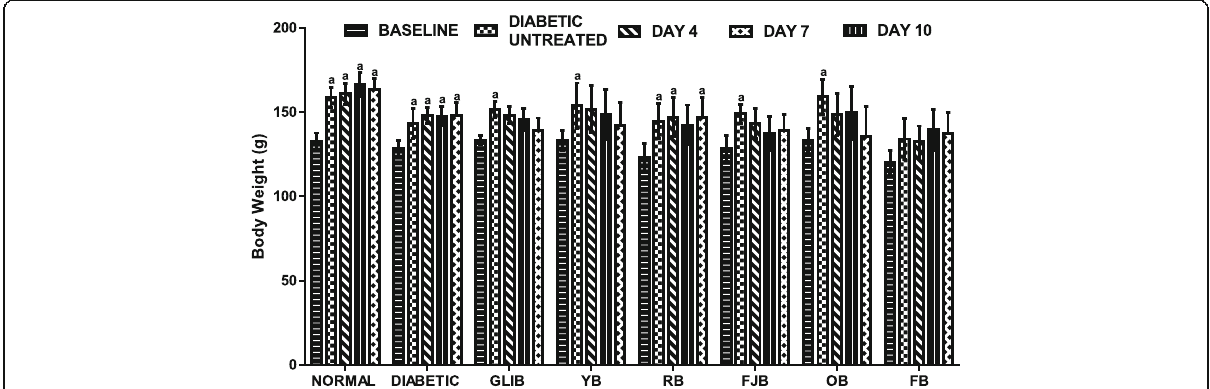
Fig. 2 effects of polyherbals on body weight in normal and diabetic rats. Results represented as Mean ± S.E.M. n = 6. a p < 0.05 different from